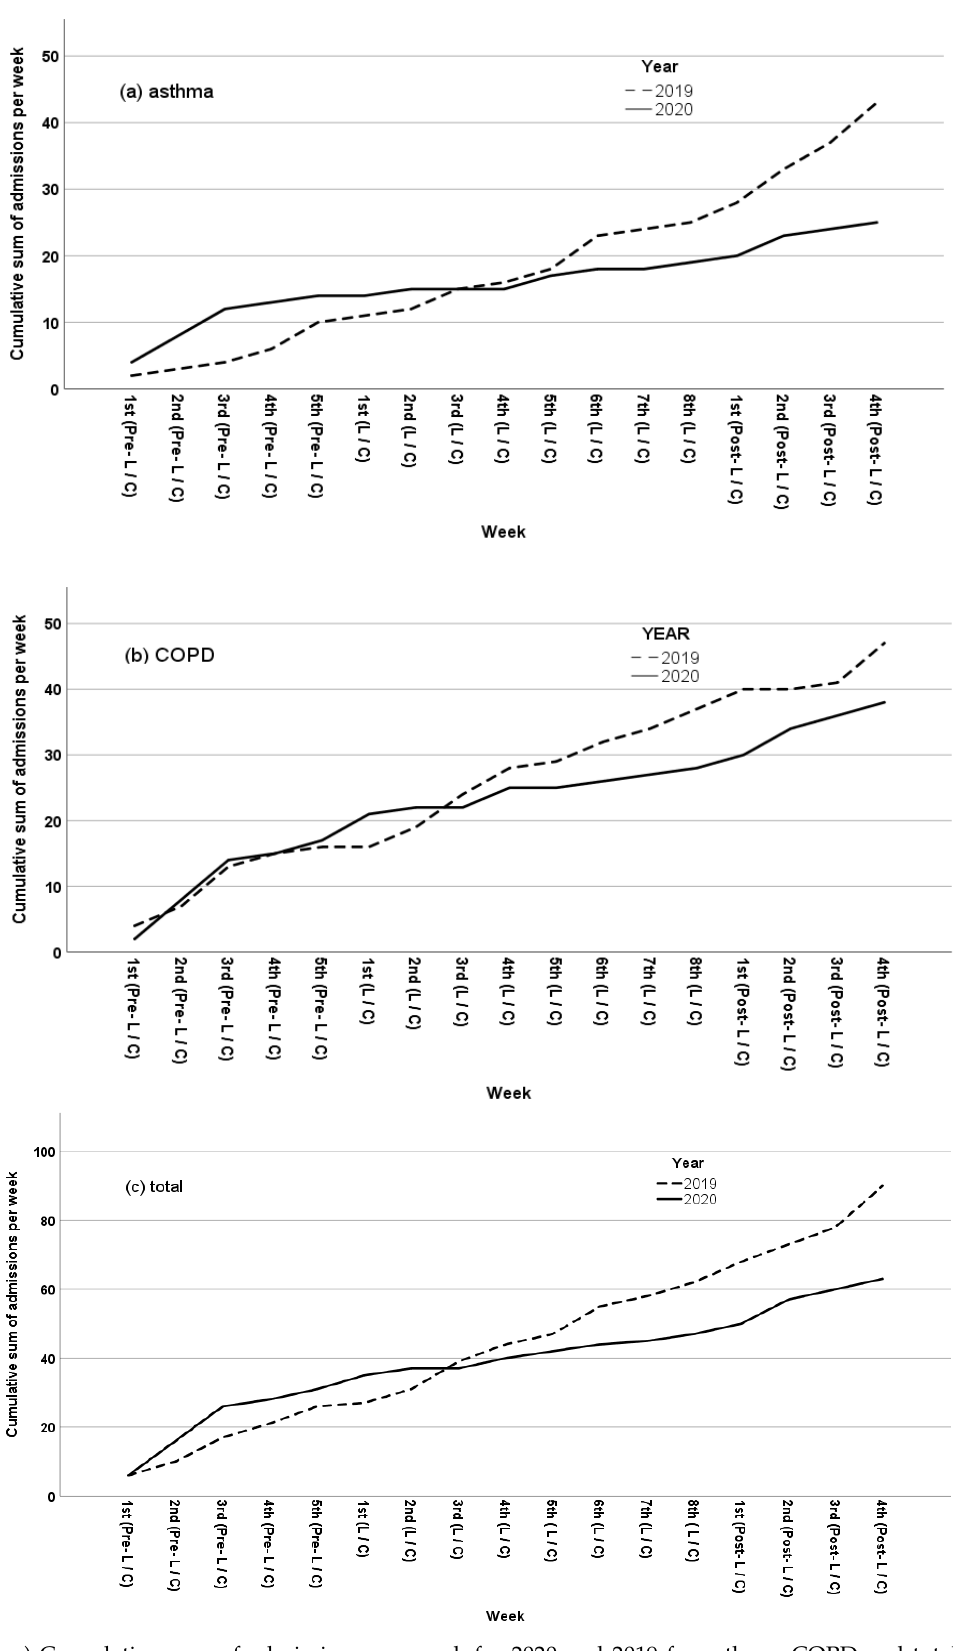
Figure 1. ( a – c ) Cumulative sum of admissions per week for 2020 and 2019 for asthma, COPD and total admissions respectively. L = Lockdown; C = Control